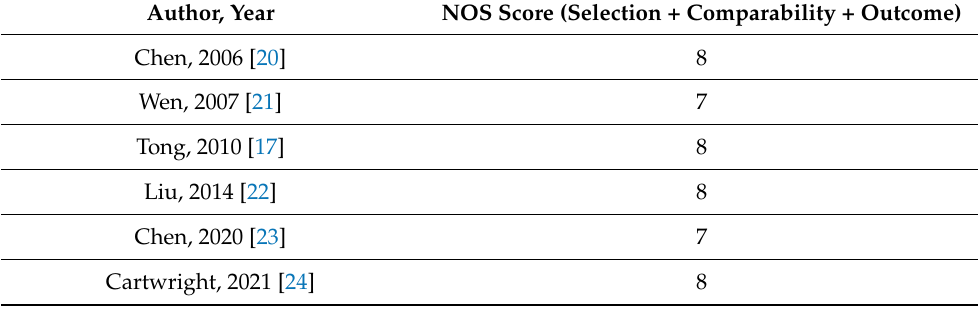
Table 1. Newcastle–Ottawa scale (NOS) assessment of included studies.